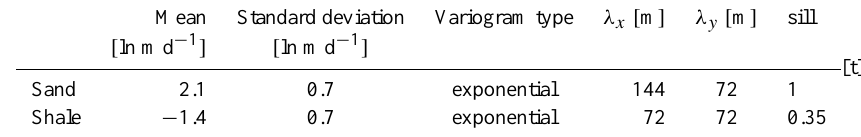
Table 1. Parameters of the random functions describing the spatial continuity of the sand and shale logconductivities.